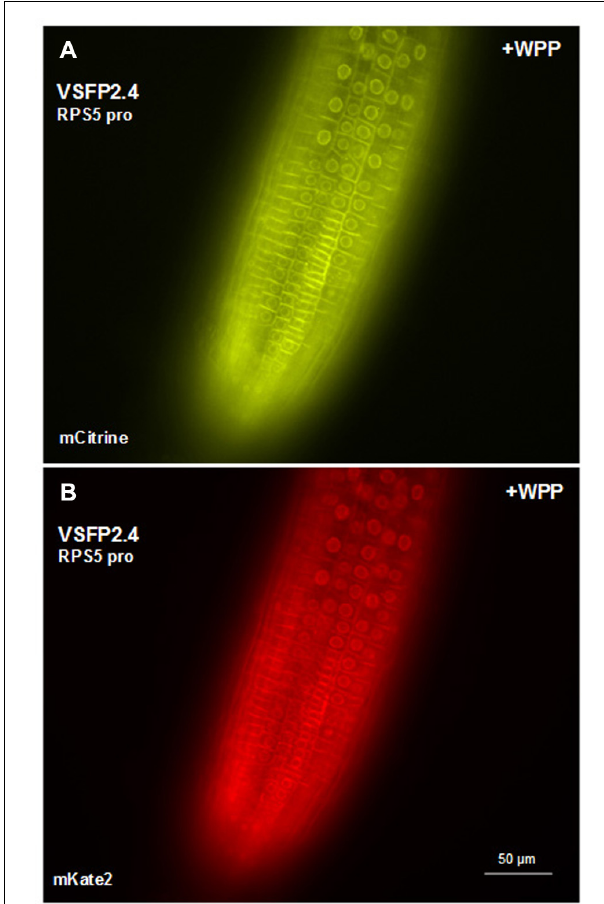
FIGURE 7 |TargetingVSFP2.4 to the outer nuclear membrane in root tip cells. VSFP2.4 (FRET pair mCitrine and mKate) under the control of the RPS5 promoter can be targeted to the outer nuclear membrane (fluorescent circles) when coupled to theWPP domain. Considerable fluorescence is still observed at the plasma membrane, so targeting is not exclusive to the ONM.This may have something to do with the particular VSFP or cell type, sinceWPP localizesVSFP2.4, under the control of the ubiquitin-10 promoter, preferentially to the ONM in cells of the root maturation zone and root hairs ( Figures 4G,H ).The background autofluorescence may also vary depending on cell type at the excitation wavelength of the donor chromophore. Images shown are fluorescence wide field images acquired after focusing on nuclei in the top cell layer of the root. Each image was made using the respective excitation and emission wavelengths of the individual chromophores (see Figure 3